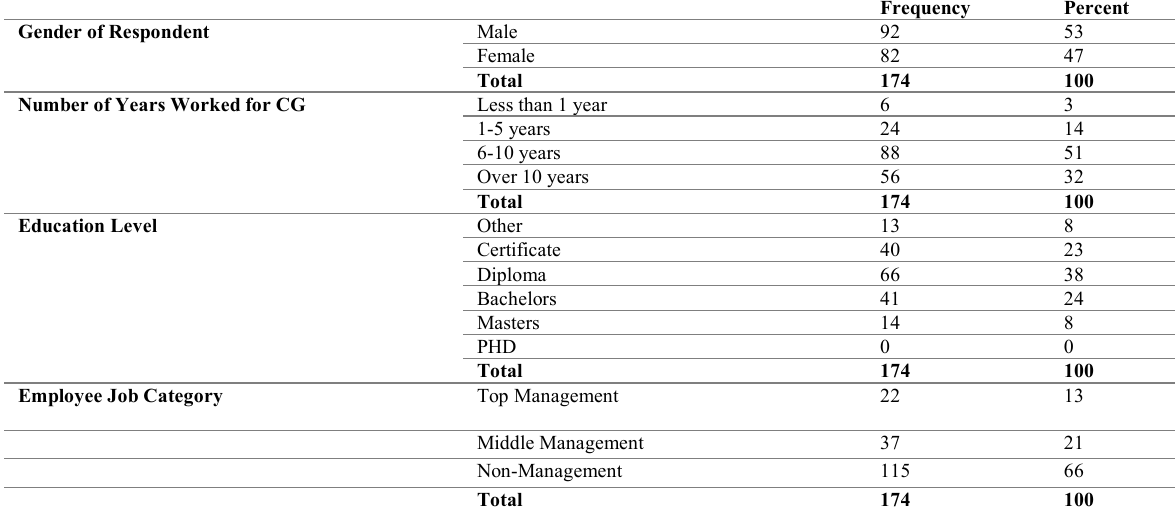
Table 1: Demographic Characteristics